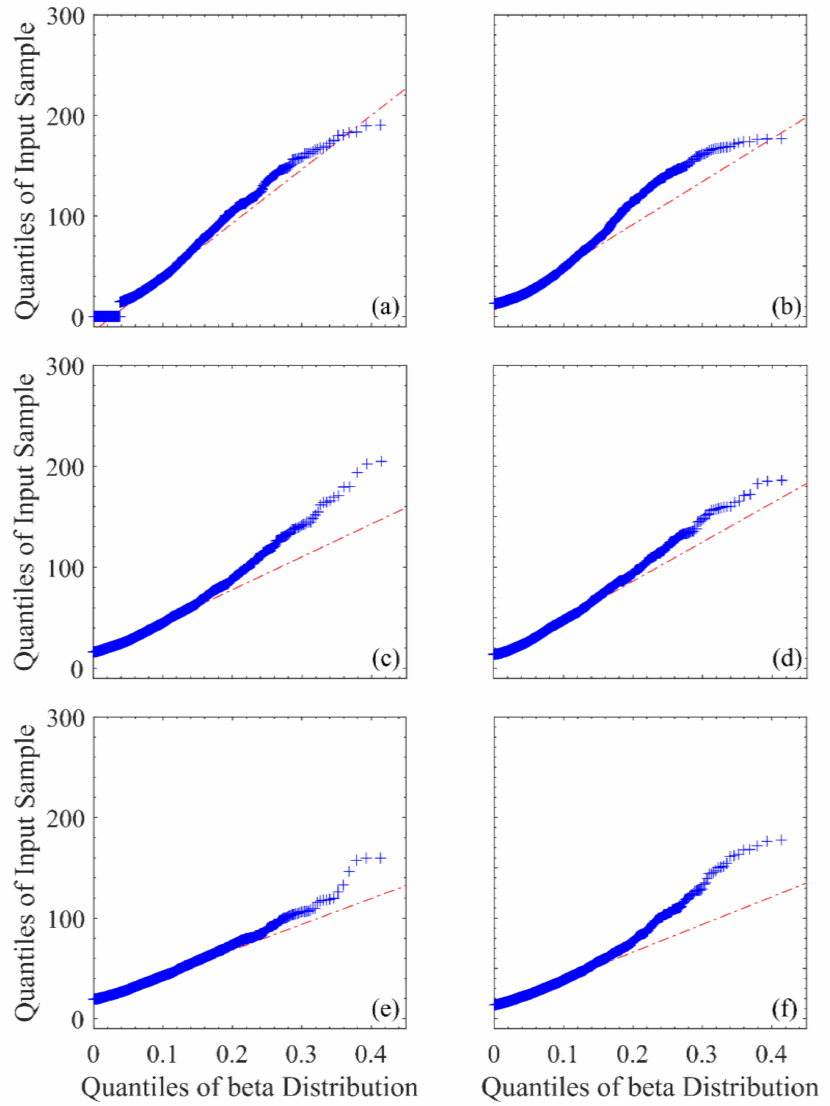
Figure A6. Q-Q plot for the resulting pore size distributions for each VISF test at 263 K considering a Beta distribution with α = 1.2 and β = 15. Tests on the left ( a , c , e ) are ON-shelf while tests on the right ( b , d , f ) are OFF-shelf. ( a , b ) are for sucrose 5%, ( c , d ) are for mannitol 5% and ( e , f ) are for dextran